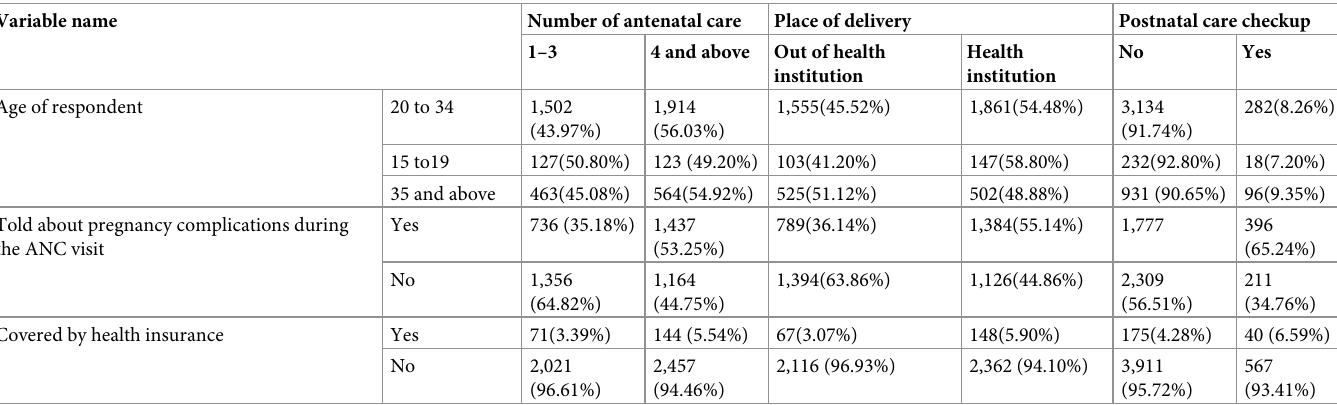
(AOR = 1.80, 95%CI: 1.49, 2.18), (AOR = 2.13, 95%CI: 1.75, 3.05), (AOR = 1.58, 95%CI: 1.26, 1.93) more odds of dropout from ANC, PNC, and institutional delivery respectively compared to their counterpart. Women who were from the poorest family had one and a half (AOR = 1.71, 95%CI: 1.12, 2.61) more odds of dropout from antenatal care visits compared to women from richest families. Women who were not married had 42% (AOR = 0.58, 95% CI: 0.38, 0.88) fewer odds of dropout from antenatal care visits compared to those who were